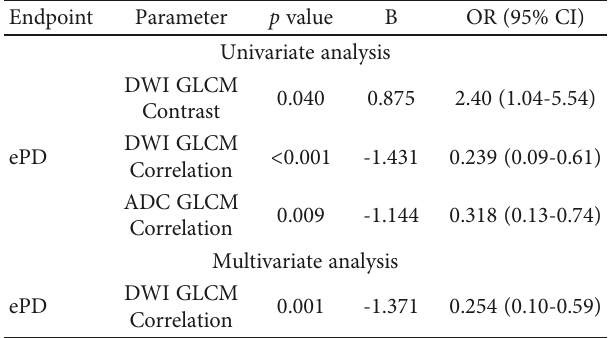
Table 2: Univariate and multivariate